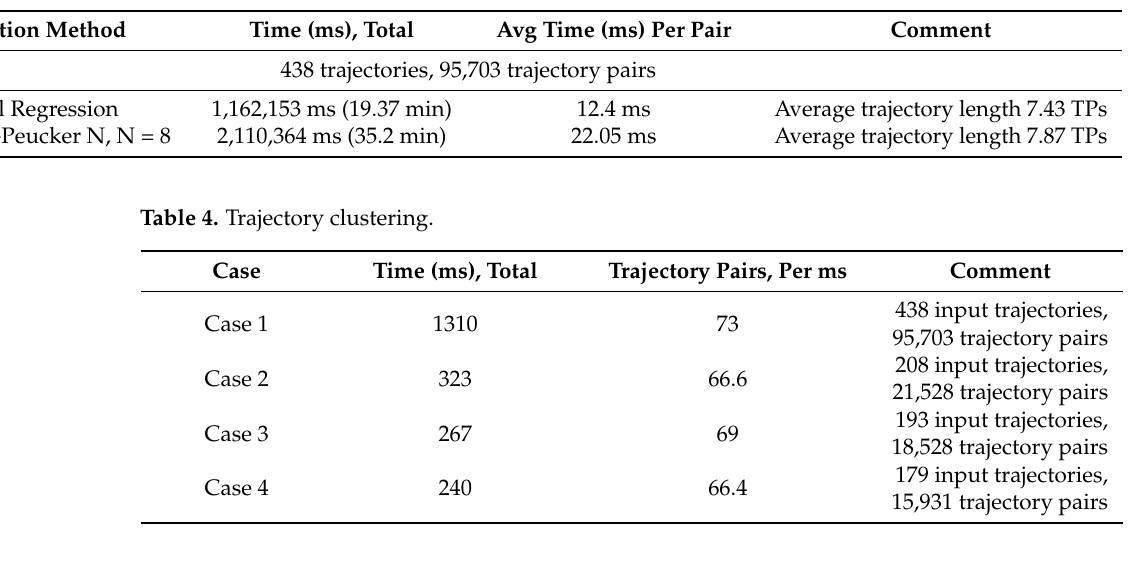
Table 3. LCSS distances calculation.